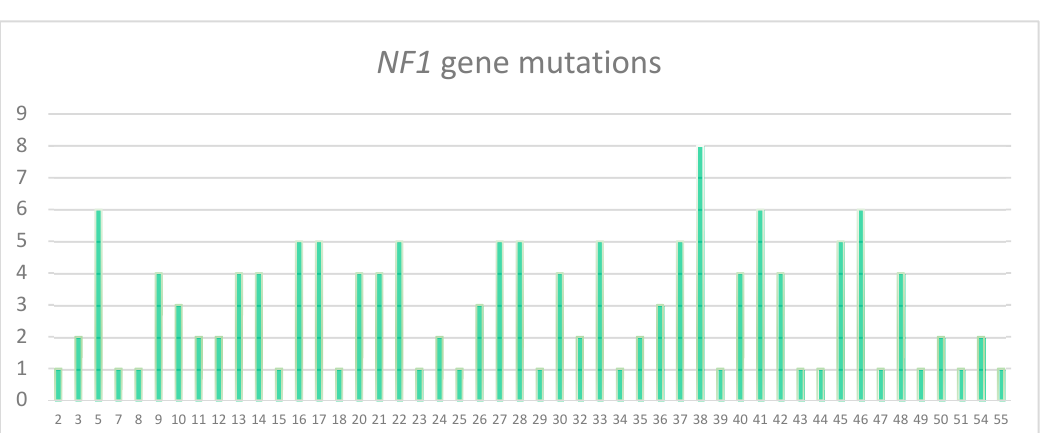
Figure 2. Distributions of the NF1 single small pathogenic variants identified for each exon.